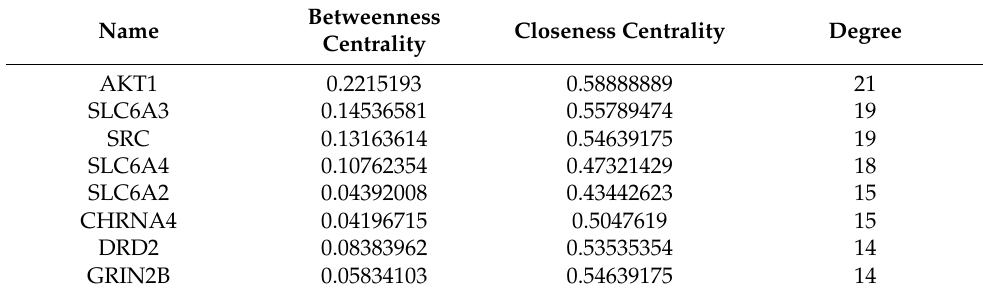
Table 1. Details of core targets of JM25-1 against